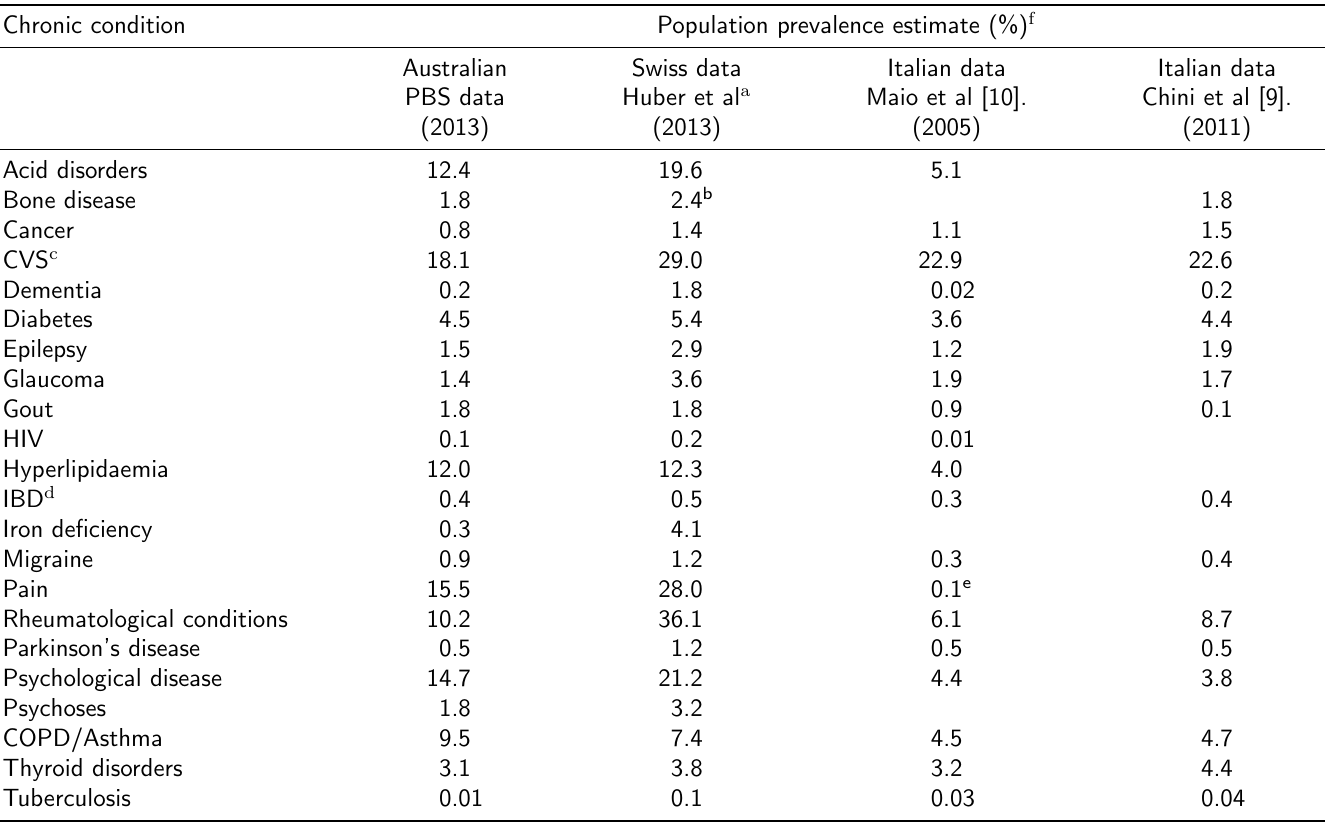
Table 2: Comparisons of Australian population chronic disease prevalence estimates with international data using administrative pharmaceutical data and ATC methodology for case